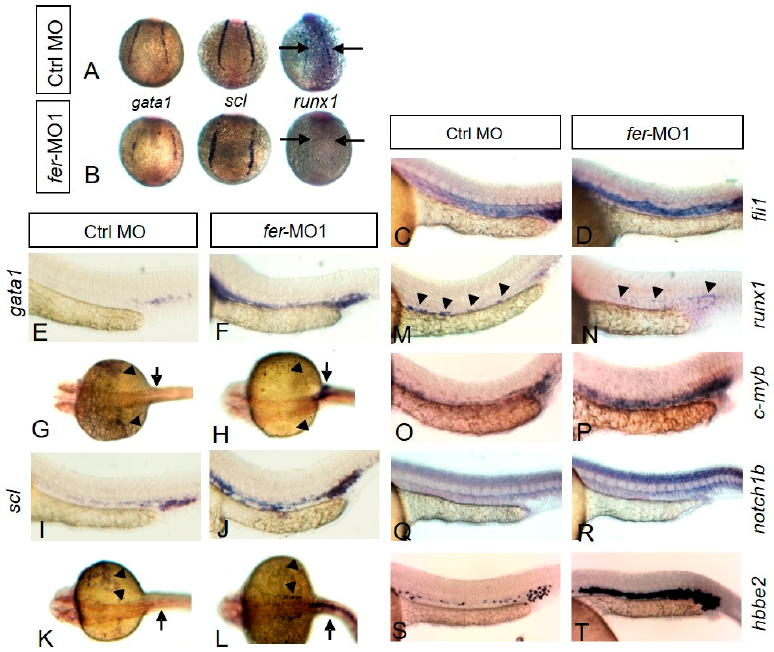
Figure 6. Fer kinase is required for proper expression patterns of hematopoietic genes. In situ hybridization showed the expression of gata1, scl and runx1 at the 6 somite stage in the region of the lateral plate mesoderm. Control embryos are shown in ( A ) while fer -MO1 embryos are shown in ( B ). Arrows point to the region of runx1 expression. At 30 somites, the expressions of fli1 ( C , D ), gata1 ( E – H ), scl ( I – L ), runx1 ( M , N ), c-myb ( O , P ), notch1b ( Q , R ), and hbbe2 ( S , T ) are shown.